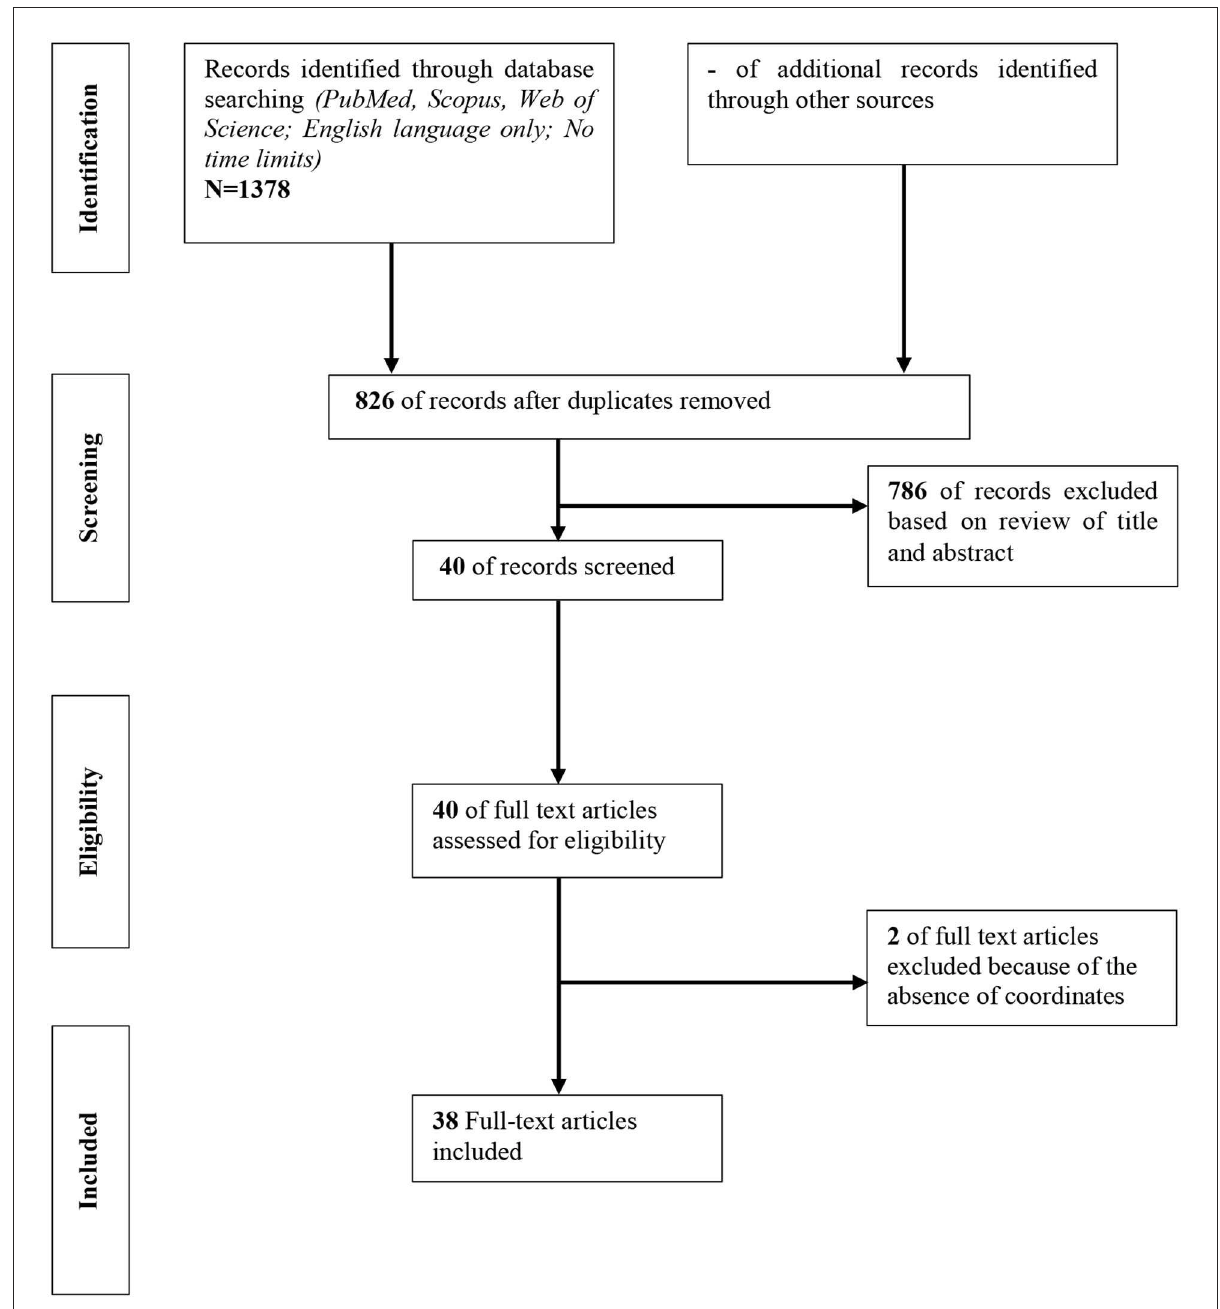
FIGURE1 Flow diagram for identifying studies in the systematic